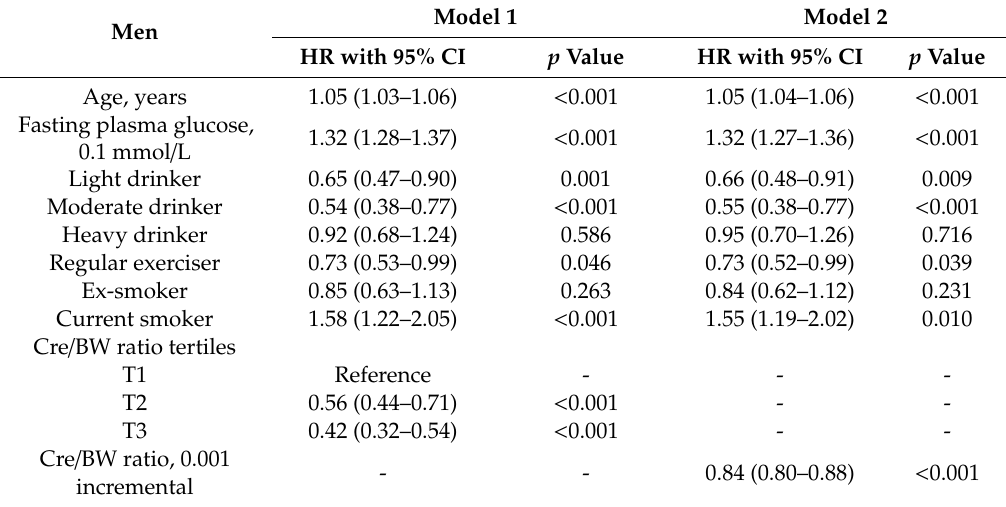
p value = 0.006 and Tertile 2 vs. Tertile 3, p value = 0.854. Table 2. Adjusted hazard ratio of incident